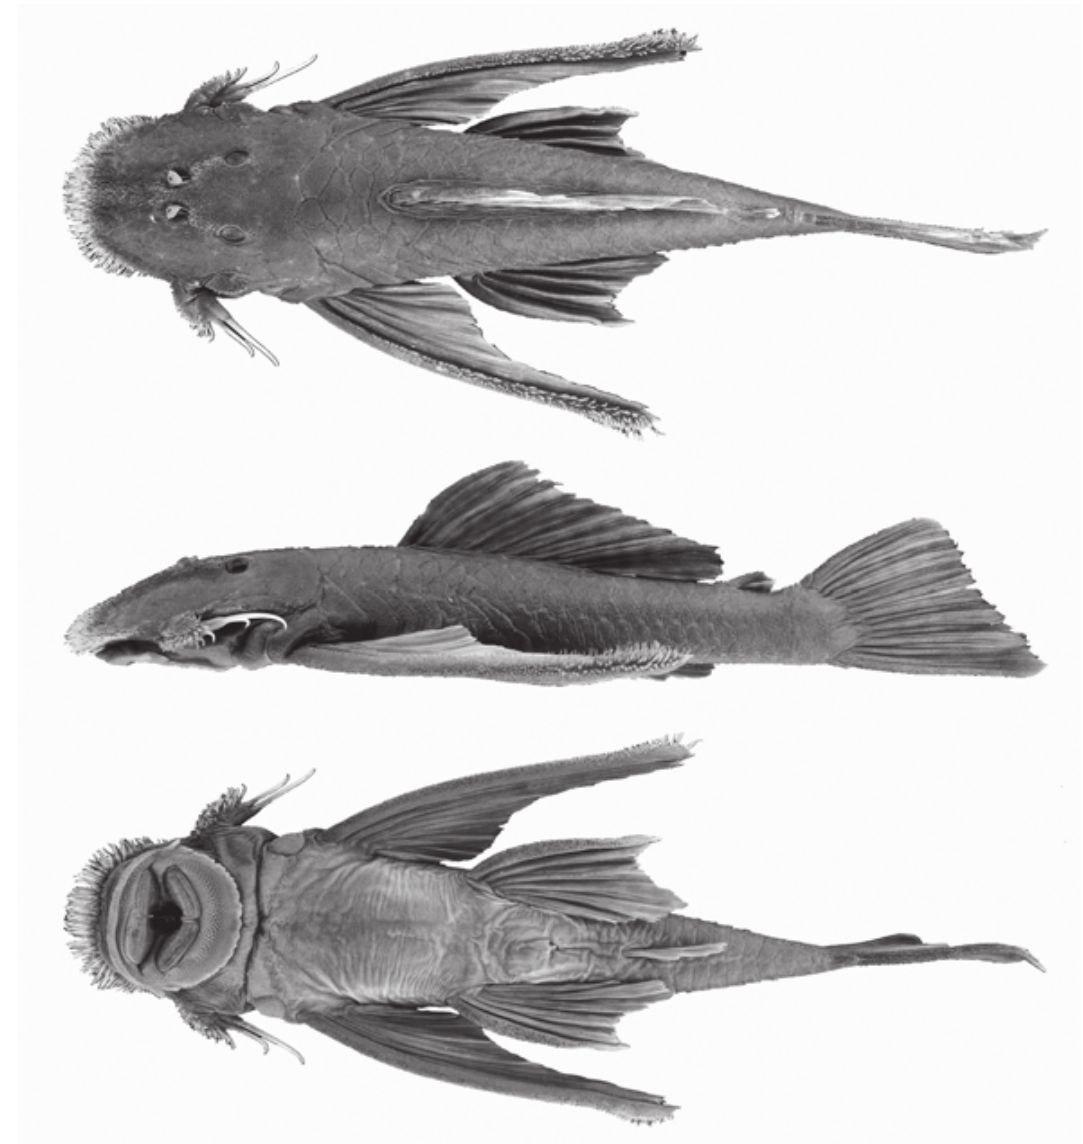
Fig. 5. Dolichancistrus fuesslii , ICNMHN 14582, 117 mm SL. Colombia, Departamento de Boyacá, río Garagoa basin; dorsal, lateral and ventral